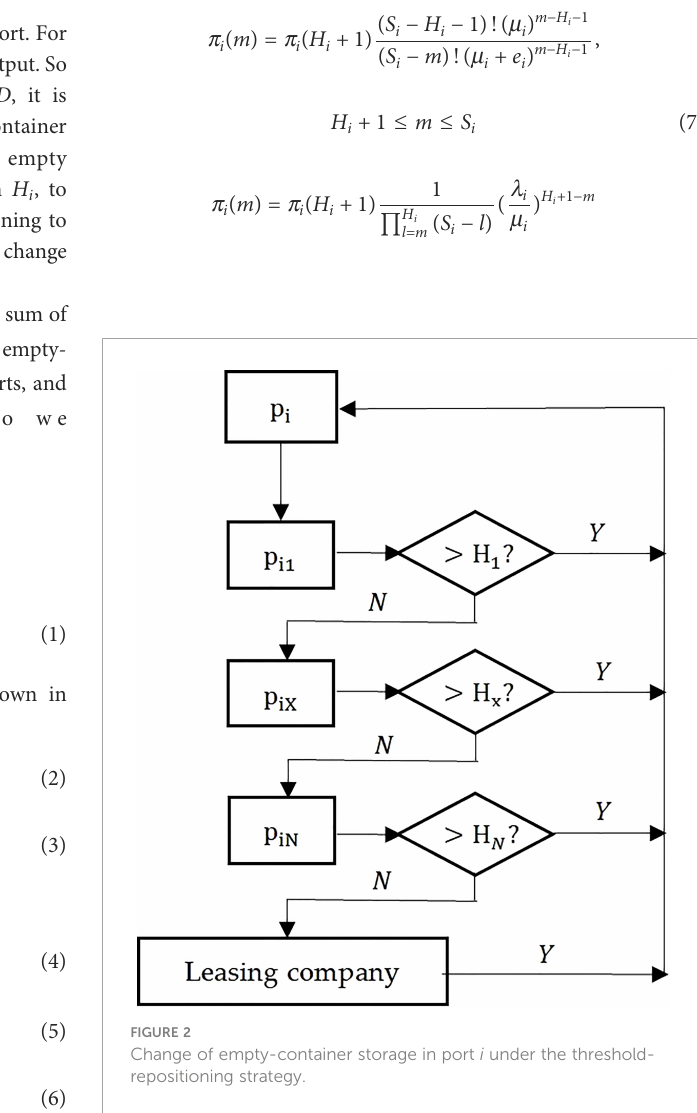
FIGURE 2 Change of empty-container storage in port i under the threshold- repositioning strategy.